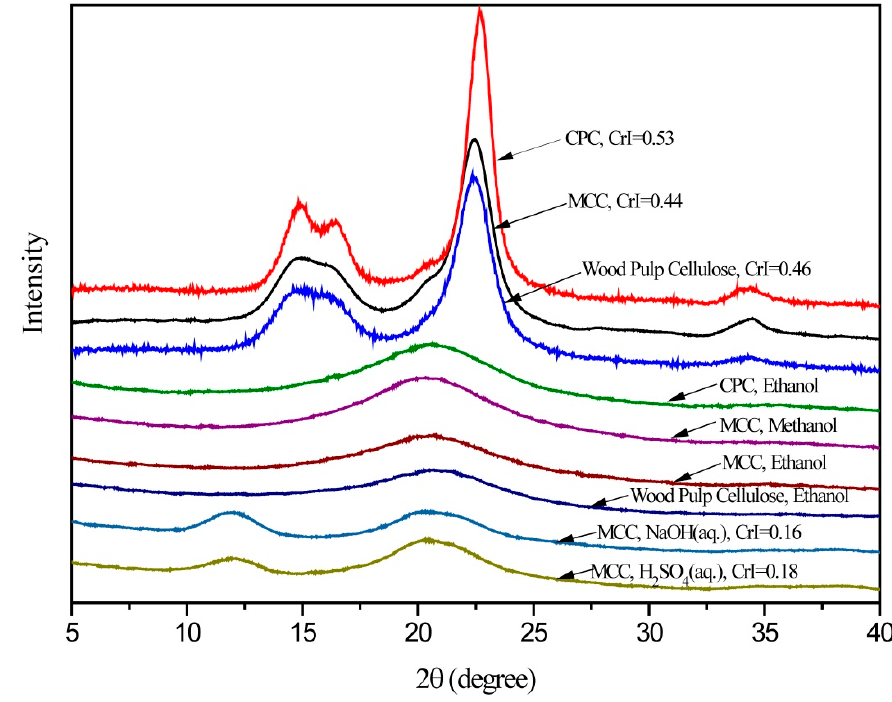
Table 1. Regeneration condition and physical properties of the cellulose films a .